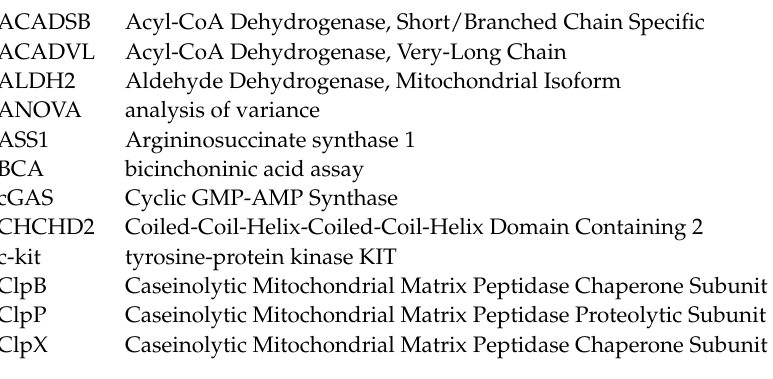
profile of ClpP-null versus WT brain tissue, STRING webserver output. Table S5. BioGRID output of protein interactors for human ClpP, ClpX, and ClpB. Table S6. Global proteome profile of primary skin fibroblasts (control n = 7, PRLTS3 n = 2 lines in biological triplicates). Table S7. Mitochondrial factors with significant accumulation in ClpP-mutant patient fibroblasts, which was at least 20% stronger in the severe PRLTS3 patient 58955 than in the milder patient 0006. Table S8. Metabolome data of ClpP-null versus WT MEFs ( n =